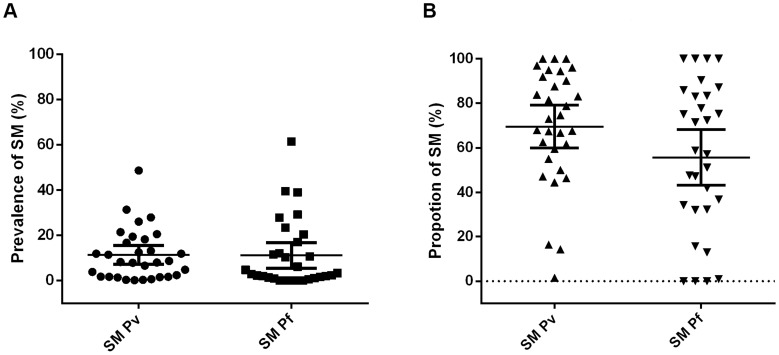
A) Comparison of SM (sub-microscopy) P. vivax and SM (sub-microscopy) P. falciparum prevalence (mean with 95% CI) in 31 cross-sectional surveys.B) Comparison of relative proportions of SM (sub-microscopy) P. vivax and P. falciparum (mean with 95% CI) in 31 cross-sectional surveys.